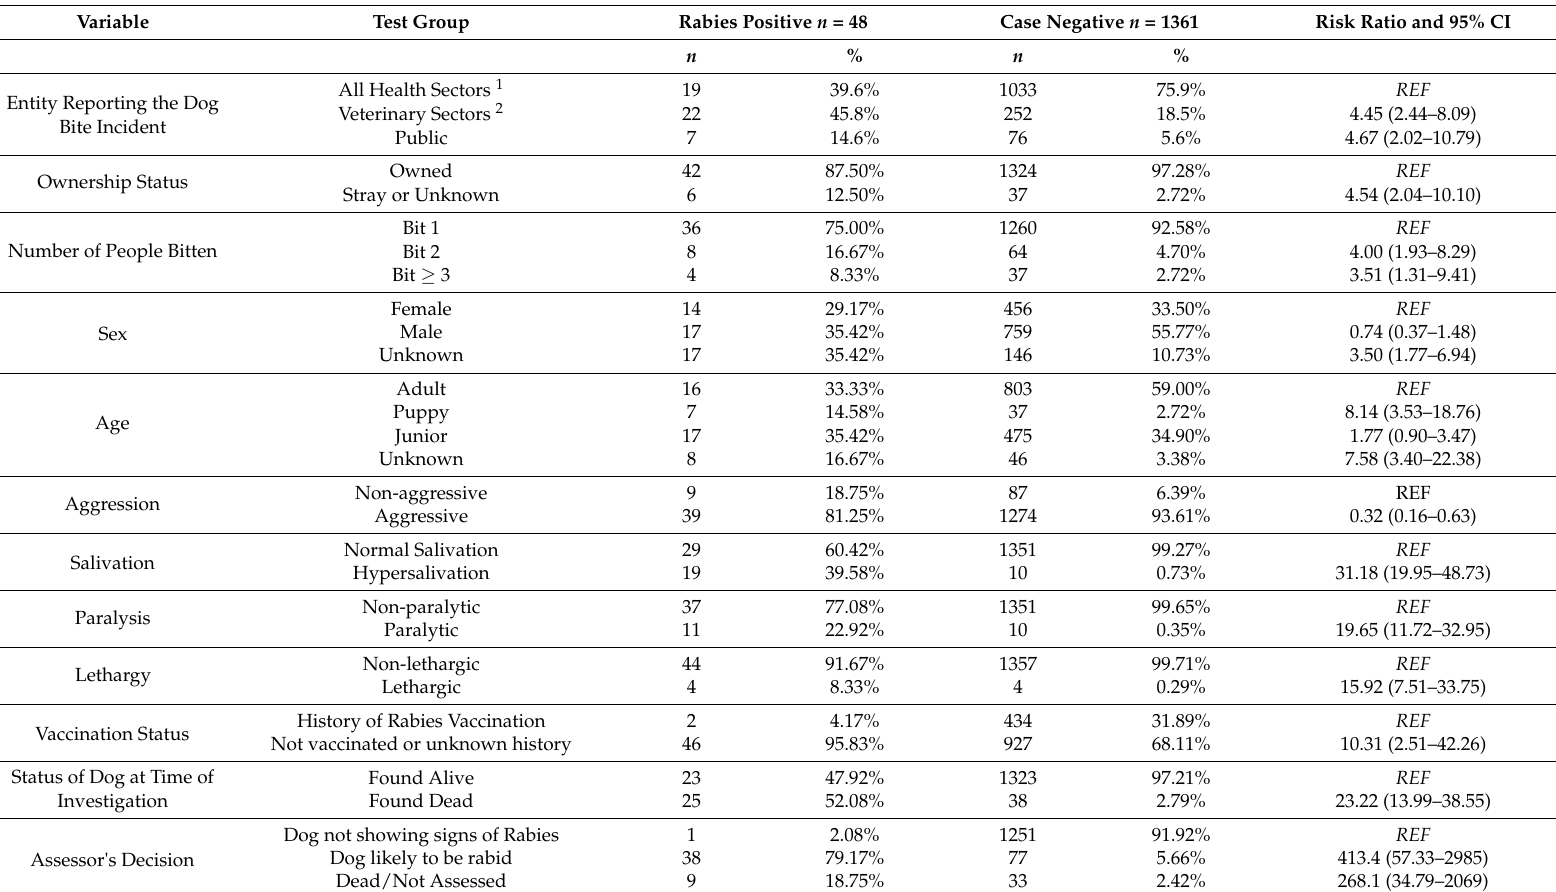
Table 2. Risk ratios of the 12 dog bite-related